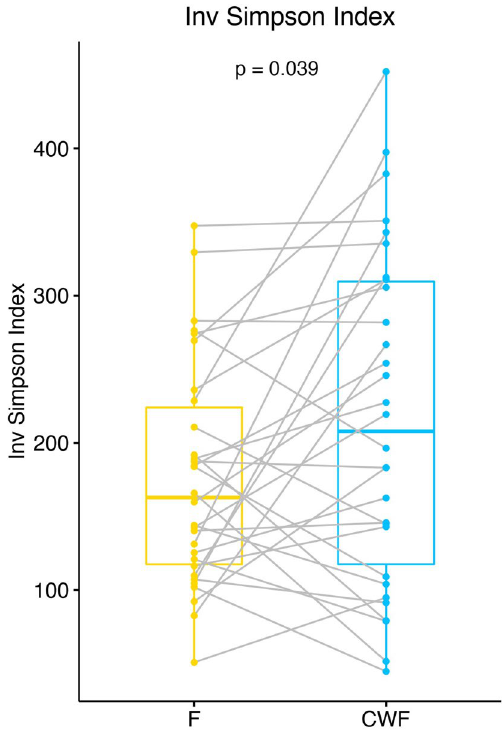
Figure 2. Dumbbell plot of alpha diversity, measured using the Inverse Simpson’s richness index, for matched F and CWF samples. Alpha diversity scores were calculated by using rarefied data at an equal sampling depth of 68,000 sequences. Box-plot and points represent the overall data distribution and samples, respectively. Samples belonging to the same enrolled subject were connected by using a grey line. The group mean comparison was performed by using the Student’s